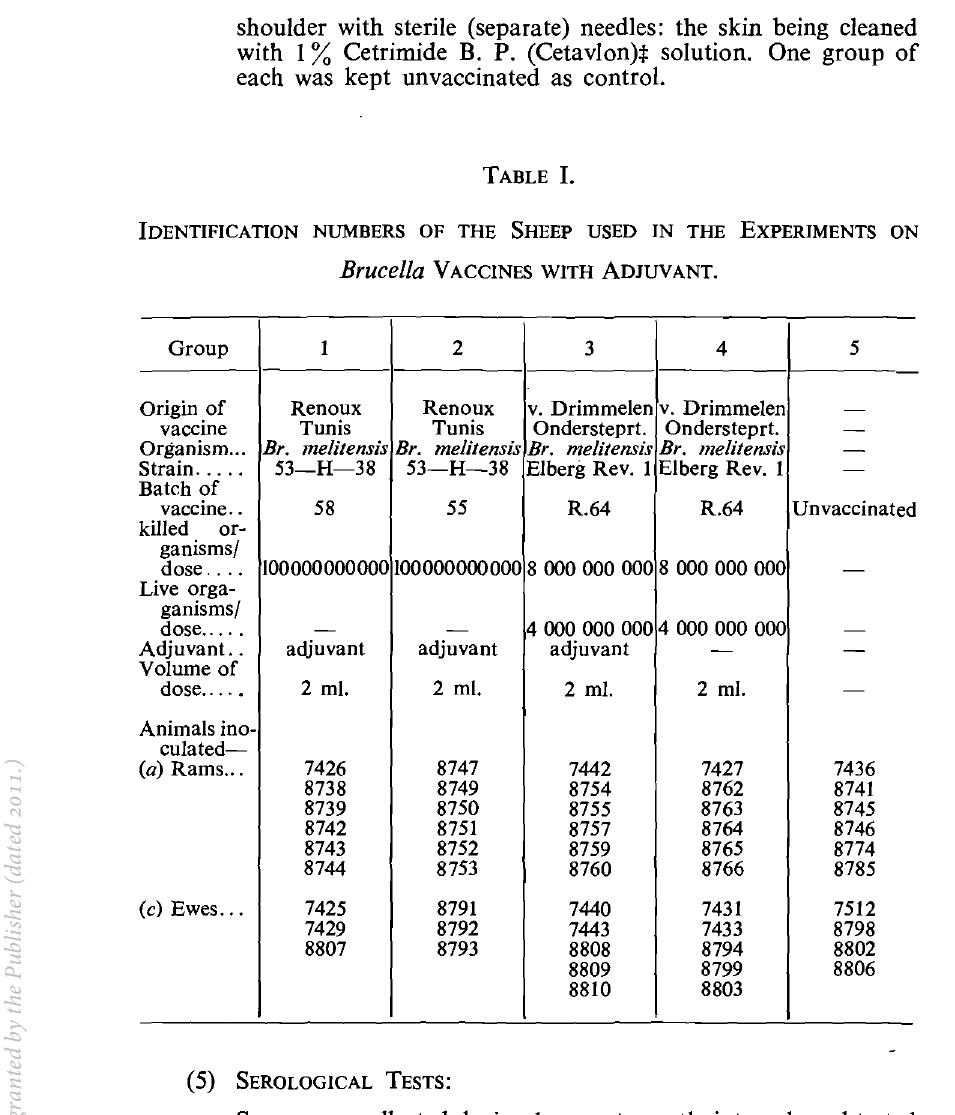
IDENTIFICATION NUMBERS OF THE SHEEP USED IN THE EXPERIMENTS ON Brucella VACCINES WITH